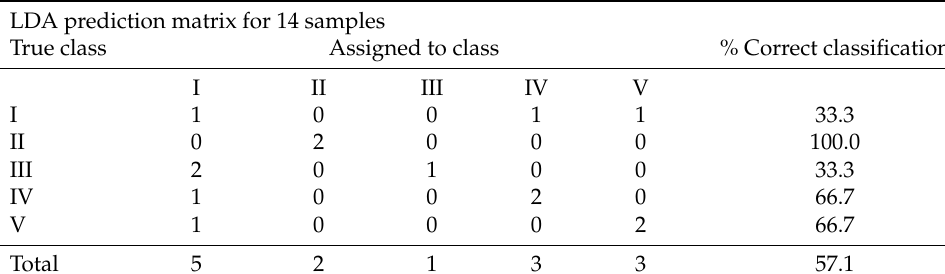
Table 4. Classification results of the classes computed by LDA.